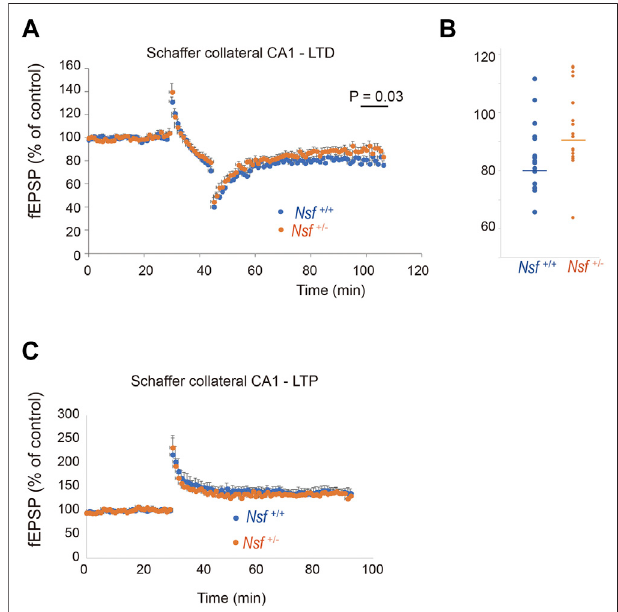
FIGURE 8 | Nsf is required for normal induction of long-term depression (LTD). (A) Electrophysiological analyses of the effects of Nsf on hippocampal LTD. LTD was induced by low-frequency stimulation (LFS; 1 Hz; 900 pulses, 15 min)oftheSchaffer collaterals inhippocampus slicesfrom Nsf +/ − and Nsf +/+ mice ( n (cid:1) 17 slices for each mouse. Mean ± SEM. Mann – Whitney U test, p (cid:1) 0.031 at the boxed time points, 97 – 106 min). A value of 100% corresponds to the pre-LFS baseline. (B) The dispersion of individual fEPSP datafor Nsf +/+ and Nsf +/ − miceatthesigni fi canttimepoint(97 – 106 min)in (A) . (C) Electrophysiological analyses of the effects of Nsf on hippocampal long- term potentiation (LTP).LTPwasinducedbyhigh-frequencystimulation (HFS) (100 Hz; 100 pulses, 1 s) of the Schaffer collaterals from Nsf +/ − and Nsf +/+ mice( n (cid:1) 6slicesfor Nsf +/ − miceand n (cid:1) 9slicesfor Nsf +/ − mice.Mean ± SEM. Student ’ s t-test, p (cid:1) 0.77). A value of 100% corresponds to the pre-LFS